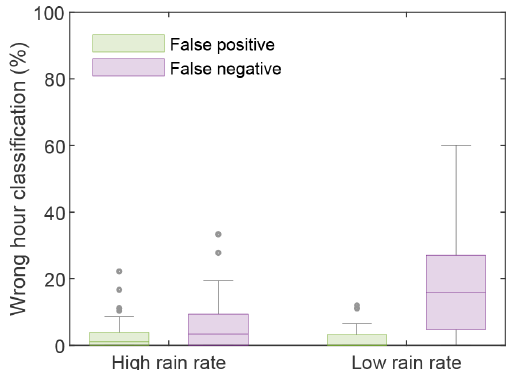
Figure 9. Box plots of (cid:49)E in each HRU for the 12 storm events (di- vided in two groups according to rainfall intensity). The box plots display the median, the 0.25 (lower) and 0.75 (upper) quantiles, out- liers (computed using the interquartile range), and the minimum and maximum values excluding any